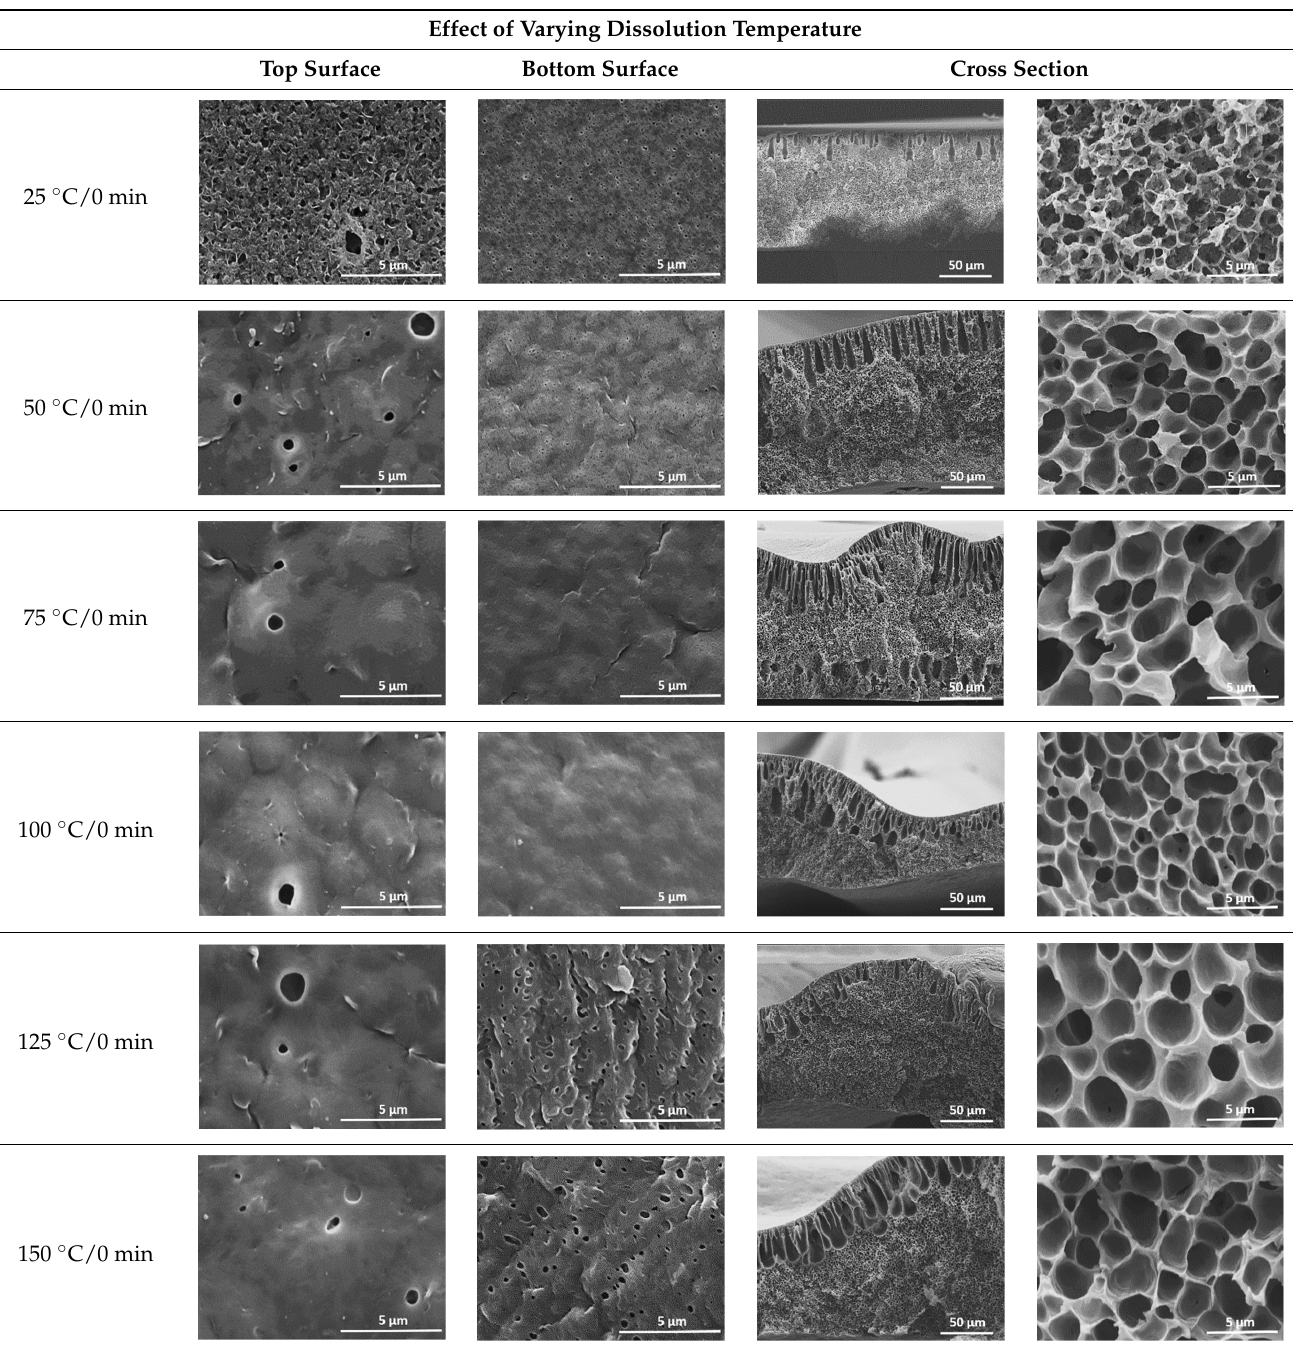
Table 1. Representative scanning electron microscopy (SEM) images of the top and bottom surfaces and cross section of the poly(vinylidene fluoride) (PVDF) membranes for different dissolution temperatures.